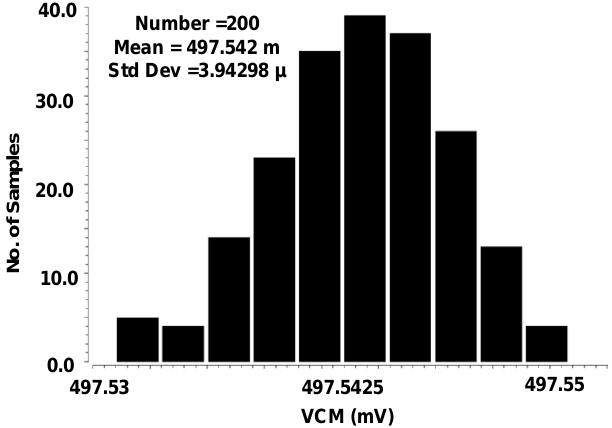
Figure 11. Monte Carlo simulation of reference voltage generator for common-mode voltage.